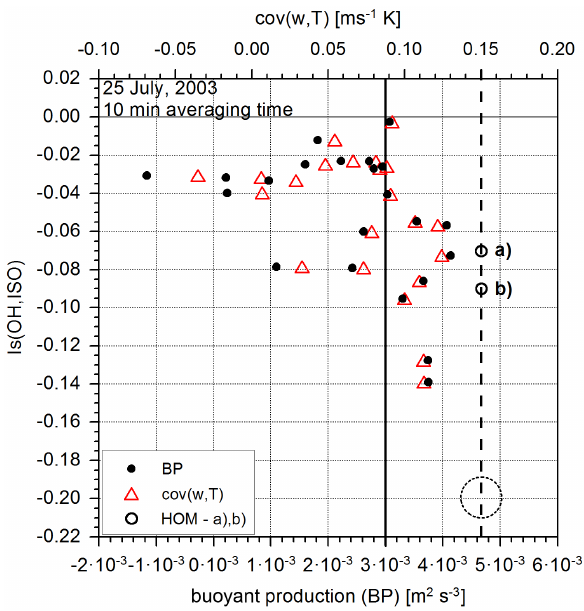
Figure 20. The intensity of segregation as a function of buoyant production (BP) and sensible heat flux H . The dotted circle and the data points labelled (a) and (b) indicates the range of results presented by Ouwersloot et al. (2011) and are explained in Sect.